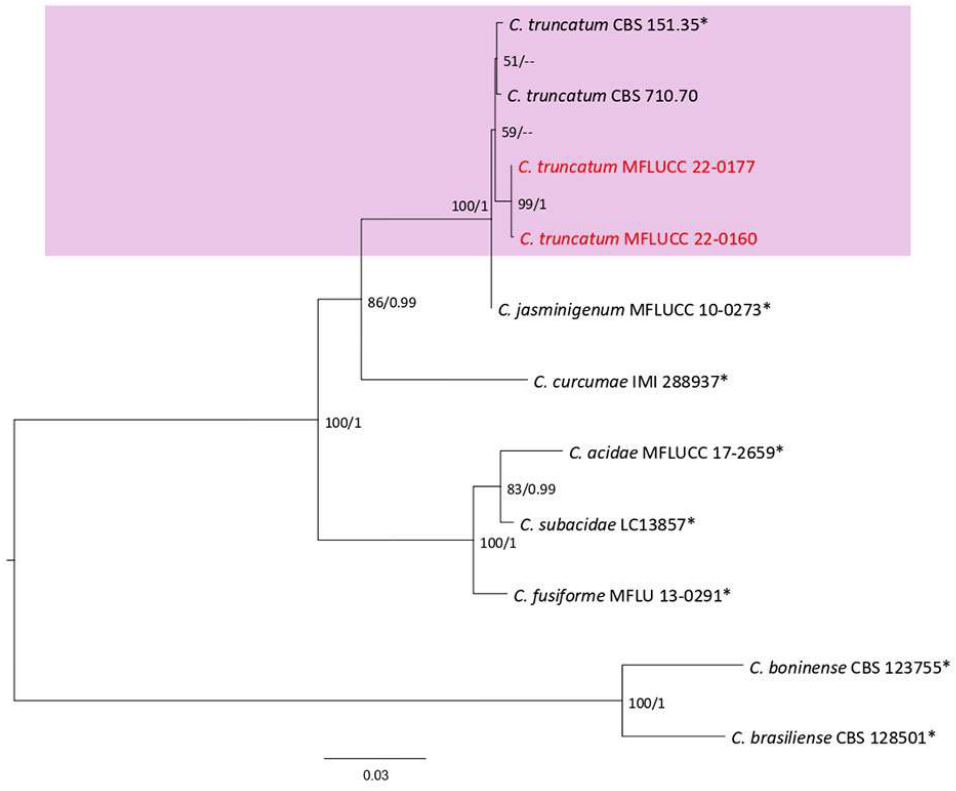
Figure 31. The Colletotrichum truncatum complex maximum likelihood phylogenetic tree obtained from combined act , chs-1 , gapdh , ITS, and tub2 sequence data. The ultrafast maximum likelihood bootstrap support (%) ≥ 50 and BYPP ≥ 0.90 are shown at the nodes. The ex-type strains are marked with an asterisk. The tree is rooted in C . boninense ( CBS 123755 ) and C . lineola ( CBS 128501 ). Colletotrichum truncatum ( Schwein .) Andrus & W . D . Moore, 1935; Figure 32.